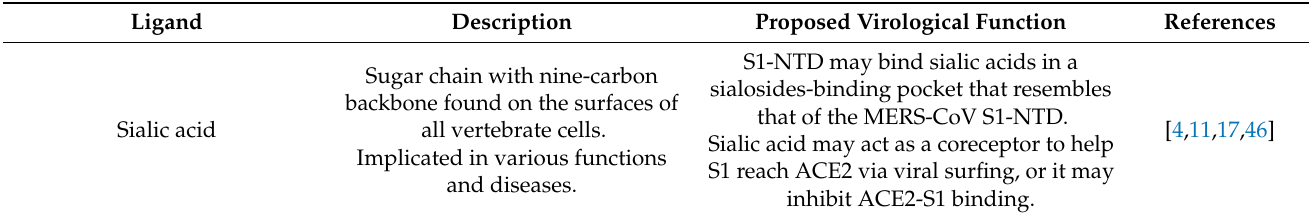
Table 1. Summary of potential coreceptor ligands of the SARS-CoV-2 spike